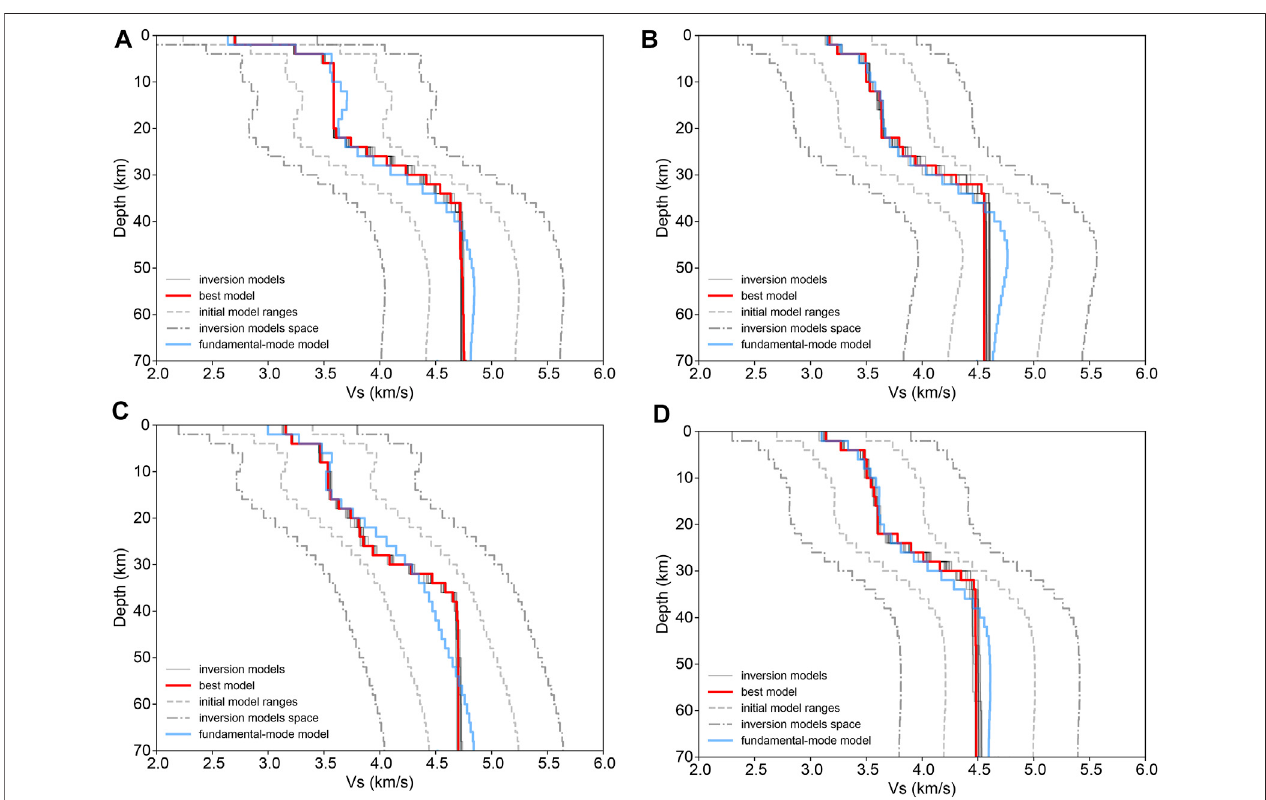
FIGURE11| Inversion results(thevelocity isprohibitedfromdecreasingwithdepth)ofthemultimodaldispersion curves. (A) THarray; (B) ZVarray; (C) subarray 1; (D) subarray 2.